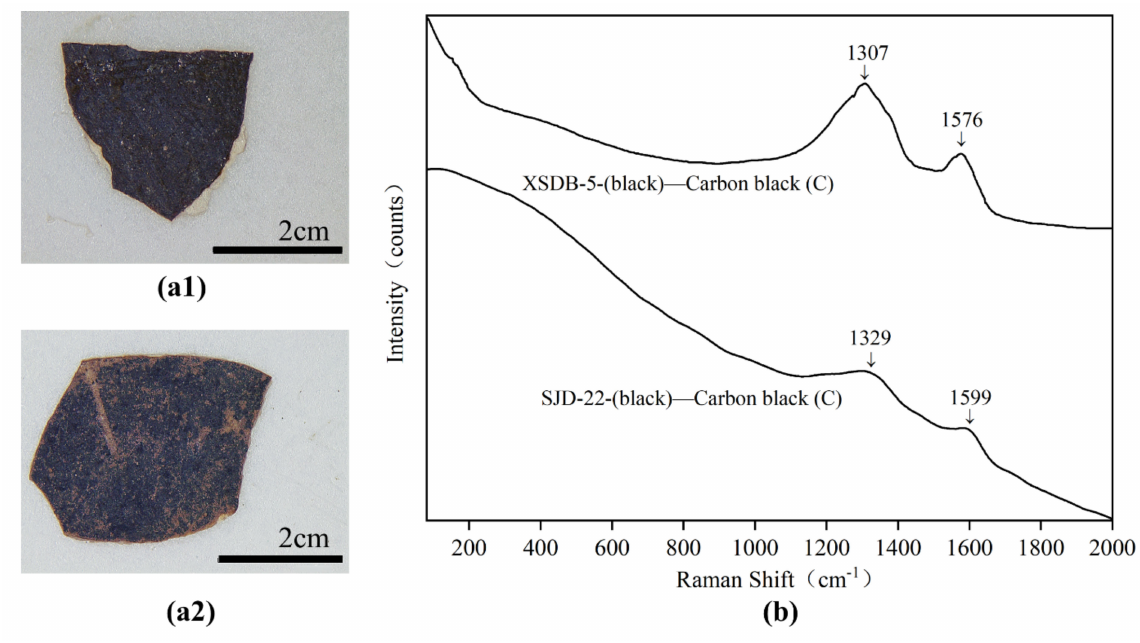
Figure 13. Digital microscopy (DM) of black samples ( a1 ) SJD-2; ( a2 ) XSBD-5 and Micro-Raman spectroscopy ( b ) SJD-2;